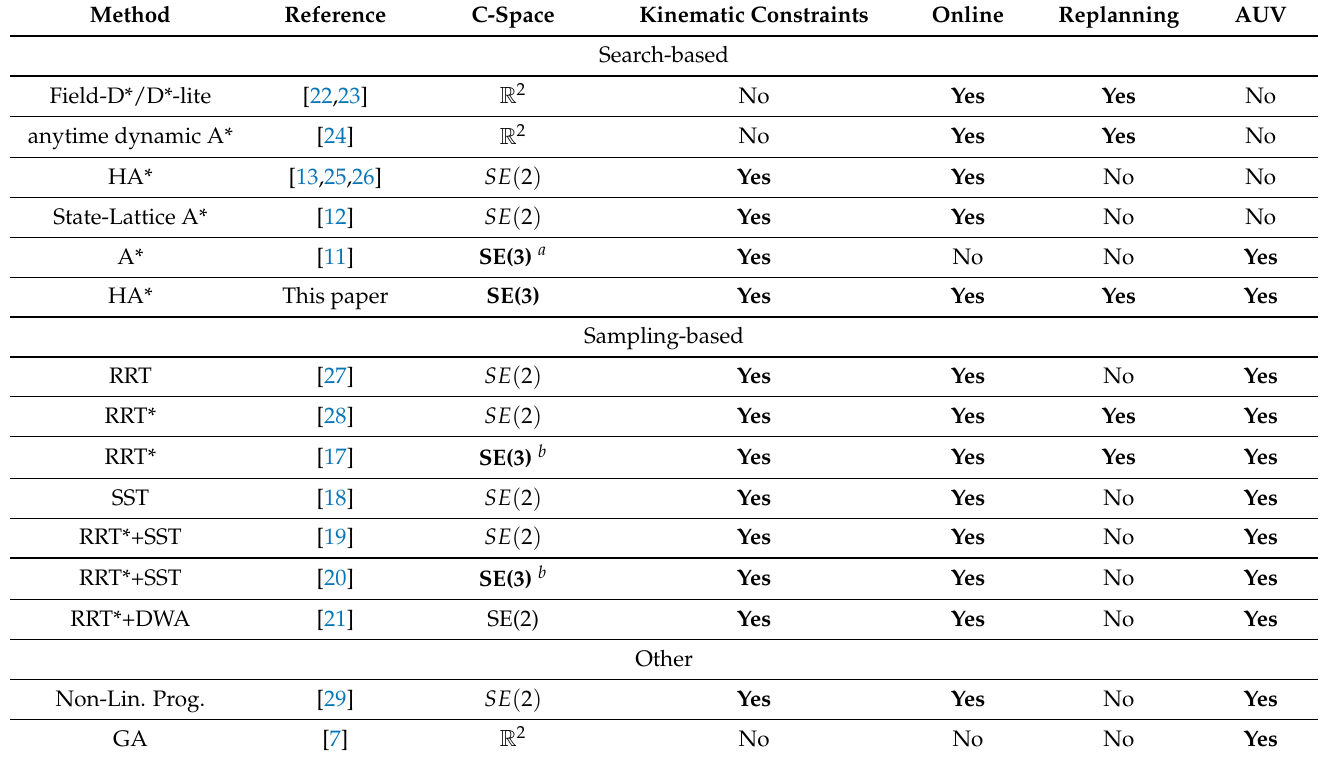
Table 1. Comparison of related work based on the dimension of the C-Space, inclusion of kinematic constraints, suitability for online planning, replanning capabilities in unknown environments and applicability for autonomous underwater vehicles (AUVs). Approaches without replanning capabilities discard their current plan and start the search for a new path without using any prior obtained knowledge about the search-space. The values in bold highlight the desired characteristics for online path planning for a non-holonomic AUV in an unknown 3D environment. a Projects the 3D map to 2D to plan in SE ( 2 ) . b Assumes hovering capabilities for the vehicle. Online Replanning